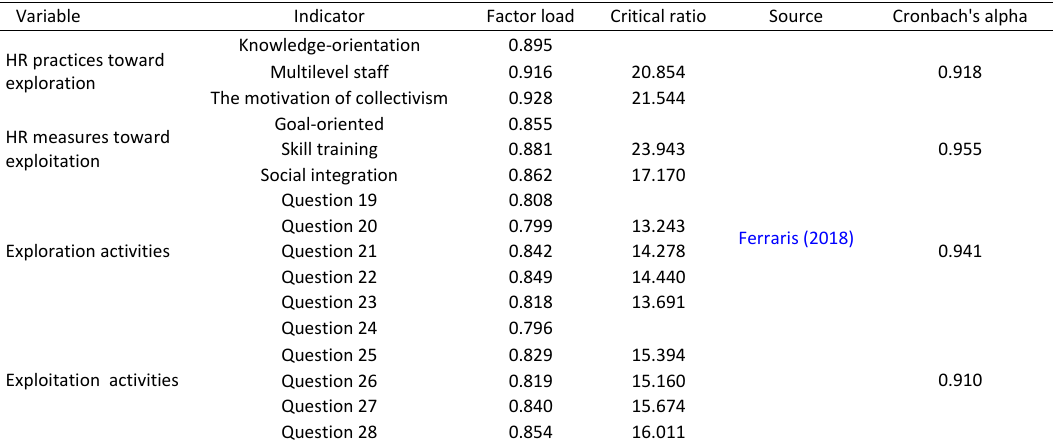
Table 1: Relationship between variables and questionnaire questions Table 1. Relationship between variables and questionnaire questions